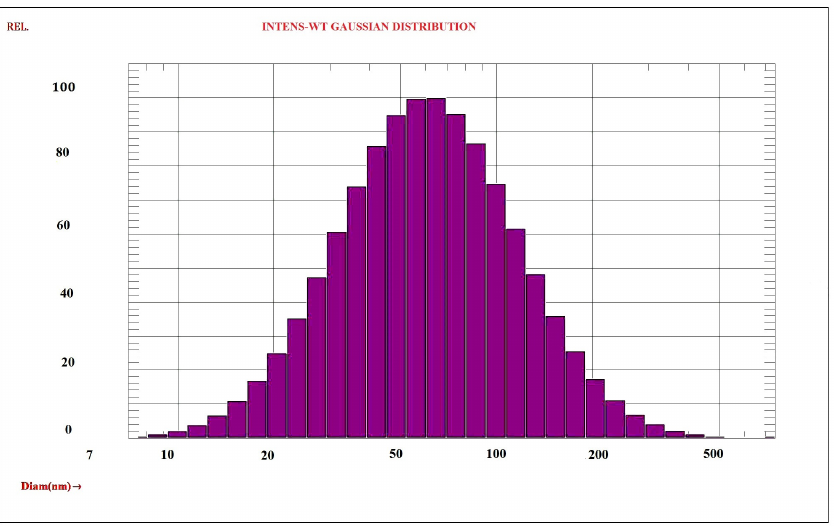
Figure 3. Dynamic light scattering histogram of green synthesized titanium dioxide nanoparticle.